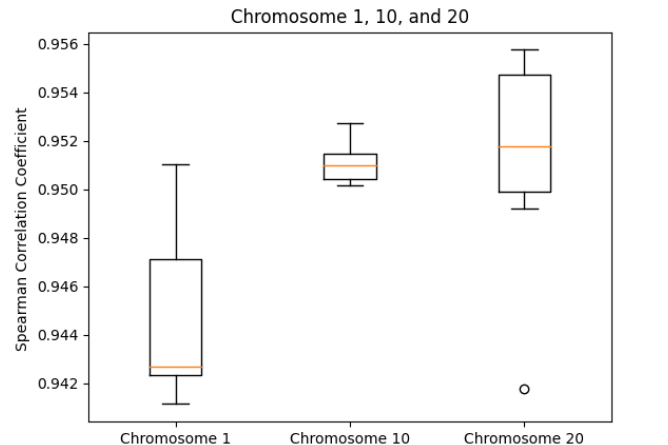
Figure 5. Runtime box plots by chromosome.